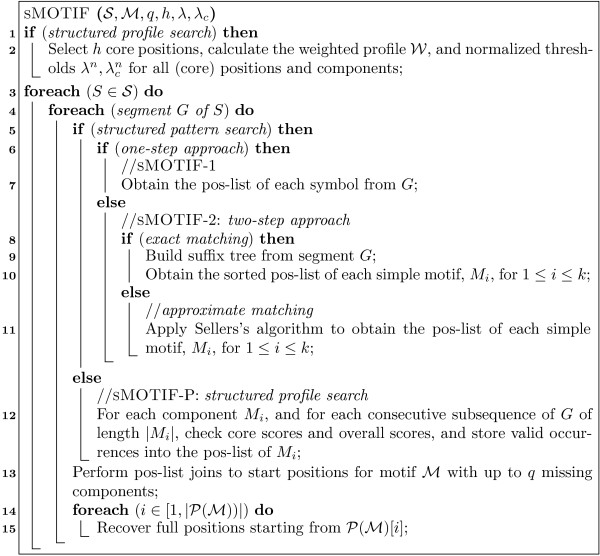
SMOTIF Algorithm.